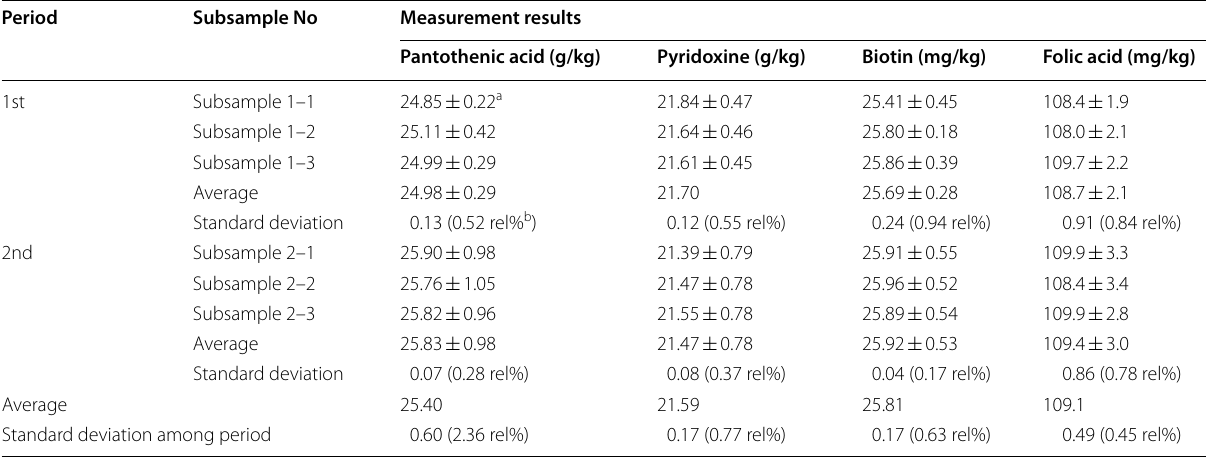
a The values following “ ” are the expanded uncertainties of the preceding values at the 95% level of confidence ± b The unit “rel%” indicates the relative percentage of the standard deviation in comparison with the corresponding mean value